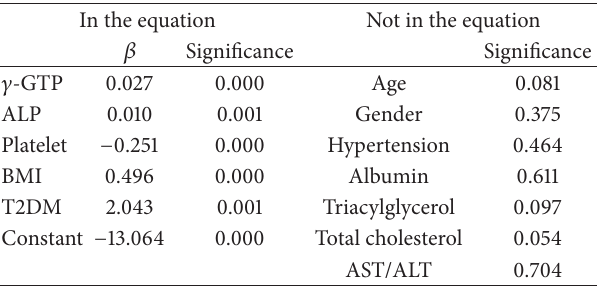
Table 3: Multivariate